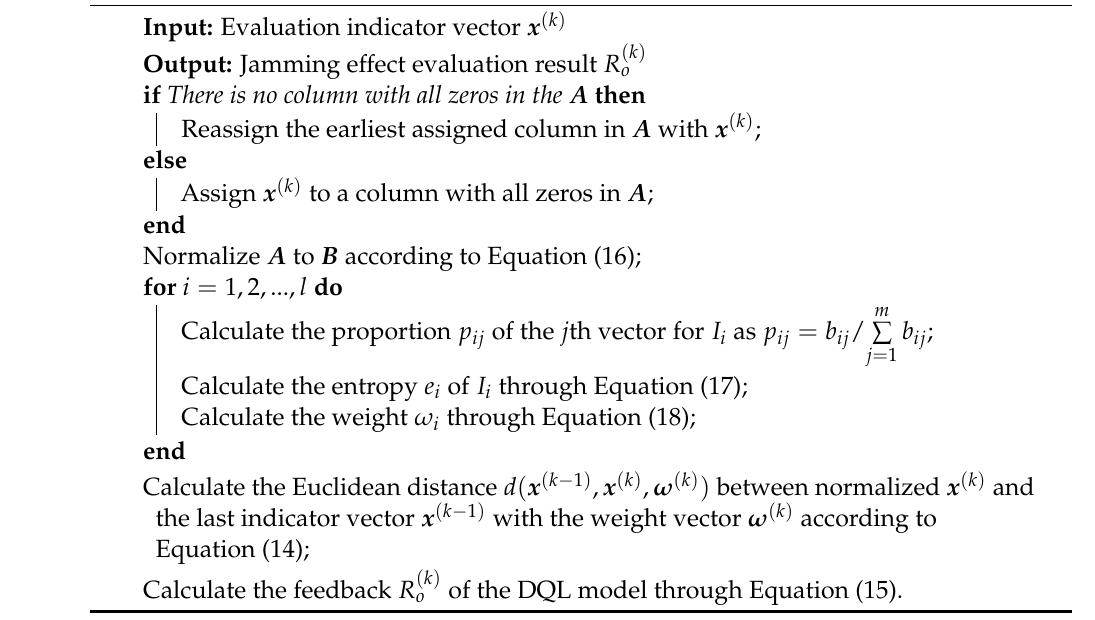
Algorithm 2: Jamming effectiveness evaluation